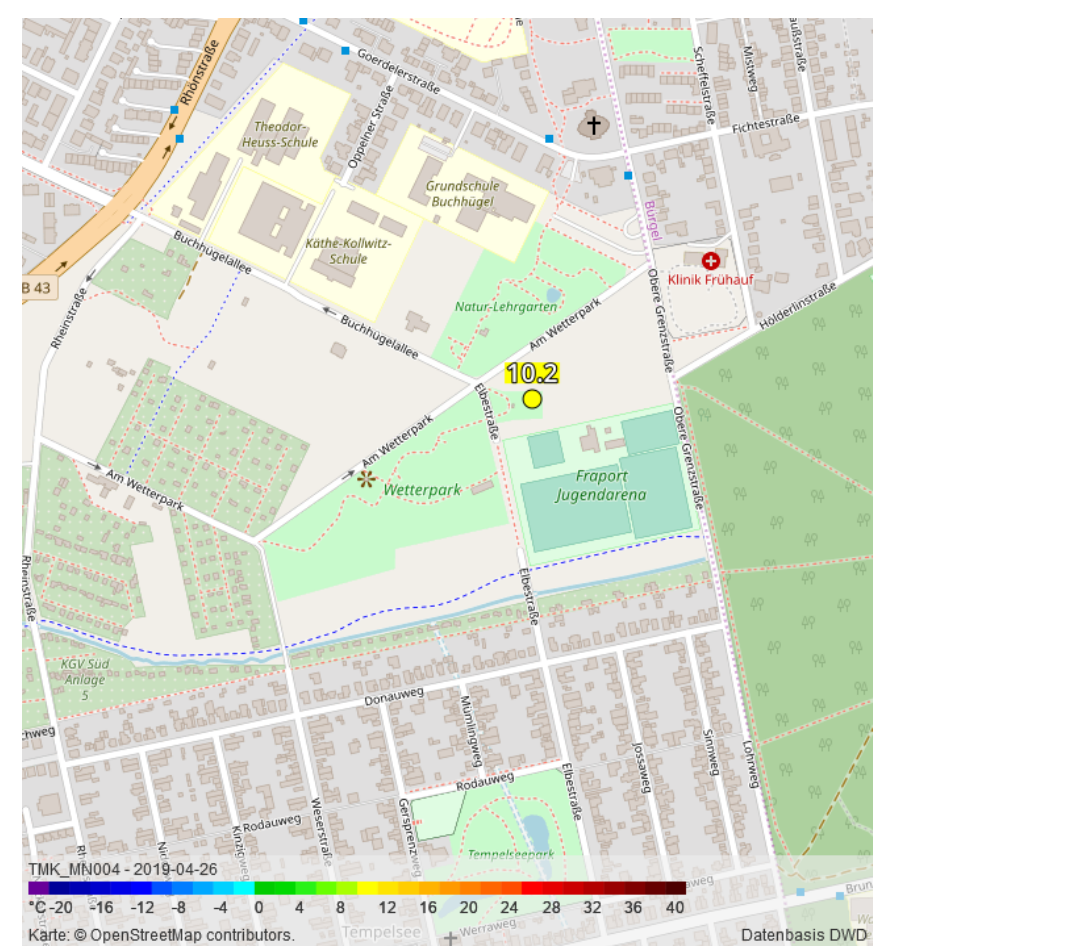
Figure 4. The station Offenbach-Wetterpark shown at a high zoom-level. The combination with additional maps (here: OpenStreetMap, © OpenStreetMap-contributors, CC BY-SA 2.0) provides detailed information on the station